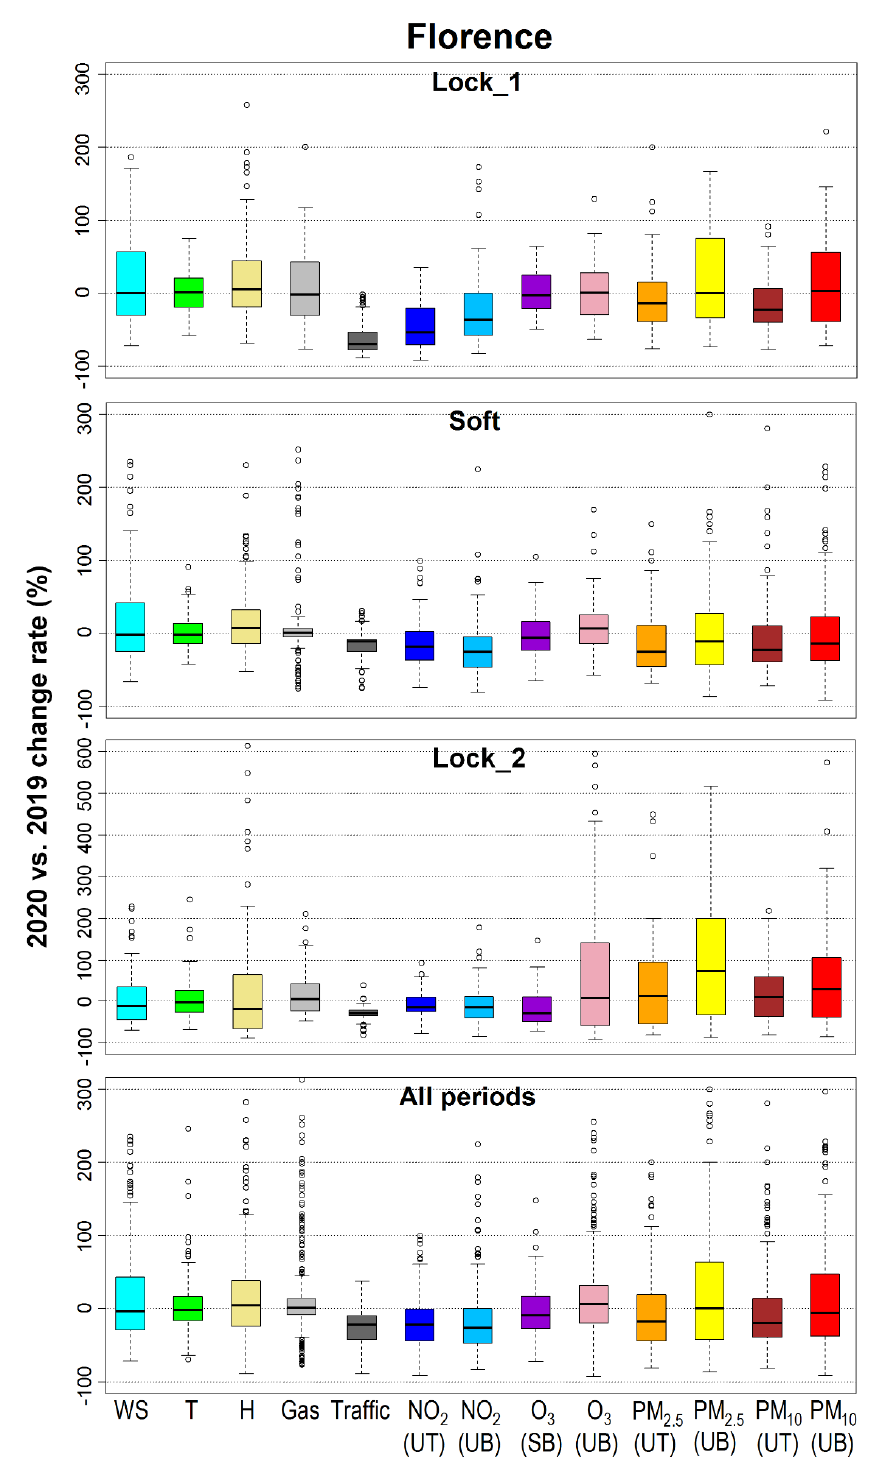
Figure 5. Boxplots by period of 2020 vs. 2019 change rates of daily observations in Florence: concentrations by station type of NO 2 , O 3 , PM 2.5 , and PM 10 ; wind speed ( WS ); air temperature ( T ); PBL height ( H ), gas consumption; road traffic. Boxplots are delimited by the first ( Q 1 ) and third ( Q 3 ) distribution’s quartiles, while the black line inside the box denotes the median value ( Q 2 ). Lower whisker is Q 1 − 1.5*IQR , while upper whisker is Q 3 + 1.5*IQR , where the interquartile range ( IQR ) is Q 3 − Q 1 . Circles outside the whiskers denote outlier data.